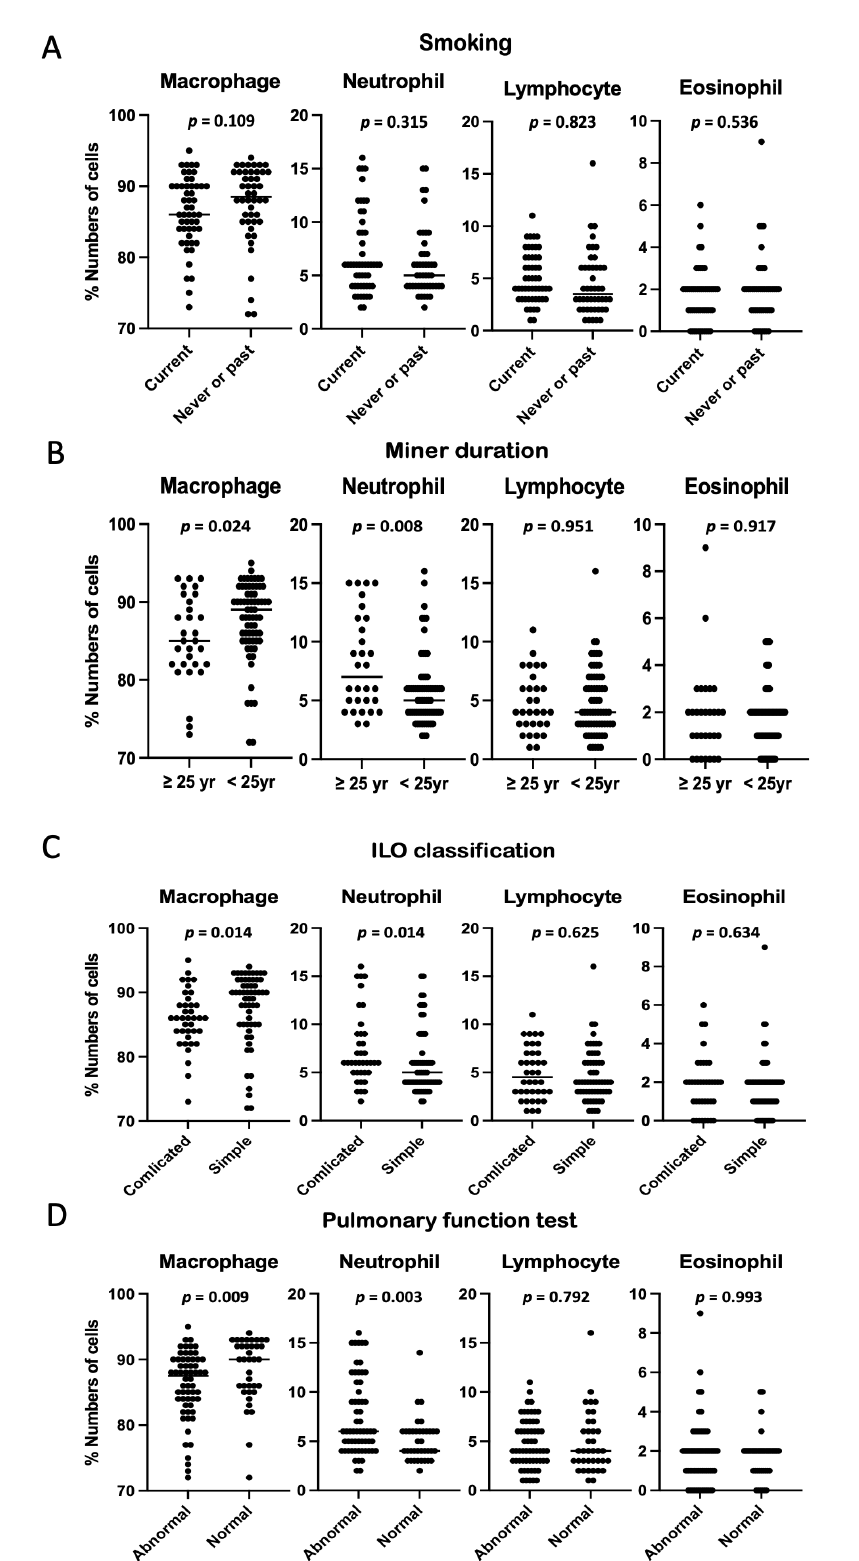
Figure 3. Demonstration of bronchoalveolar lavage differential count in coal workers’ pneumoconio- sis based on ( A ) smoking, ( B ) miner duration, ( C ) ILO classification, and ( D ) pulmonary function test. The statistical comparison of the mean of the two groups was performed with the Mann–Whitney